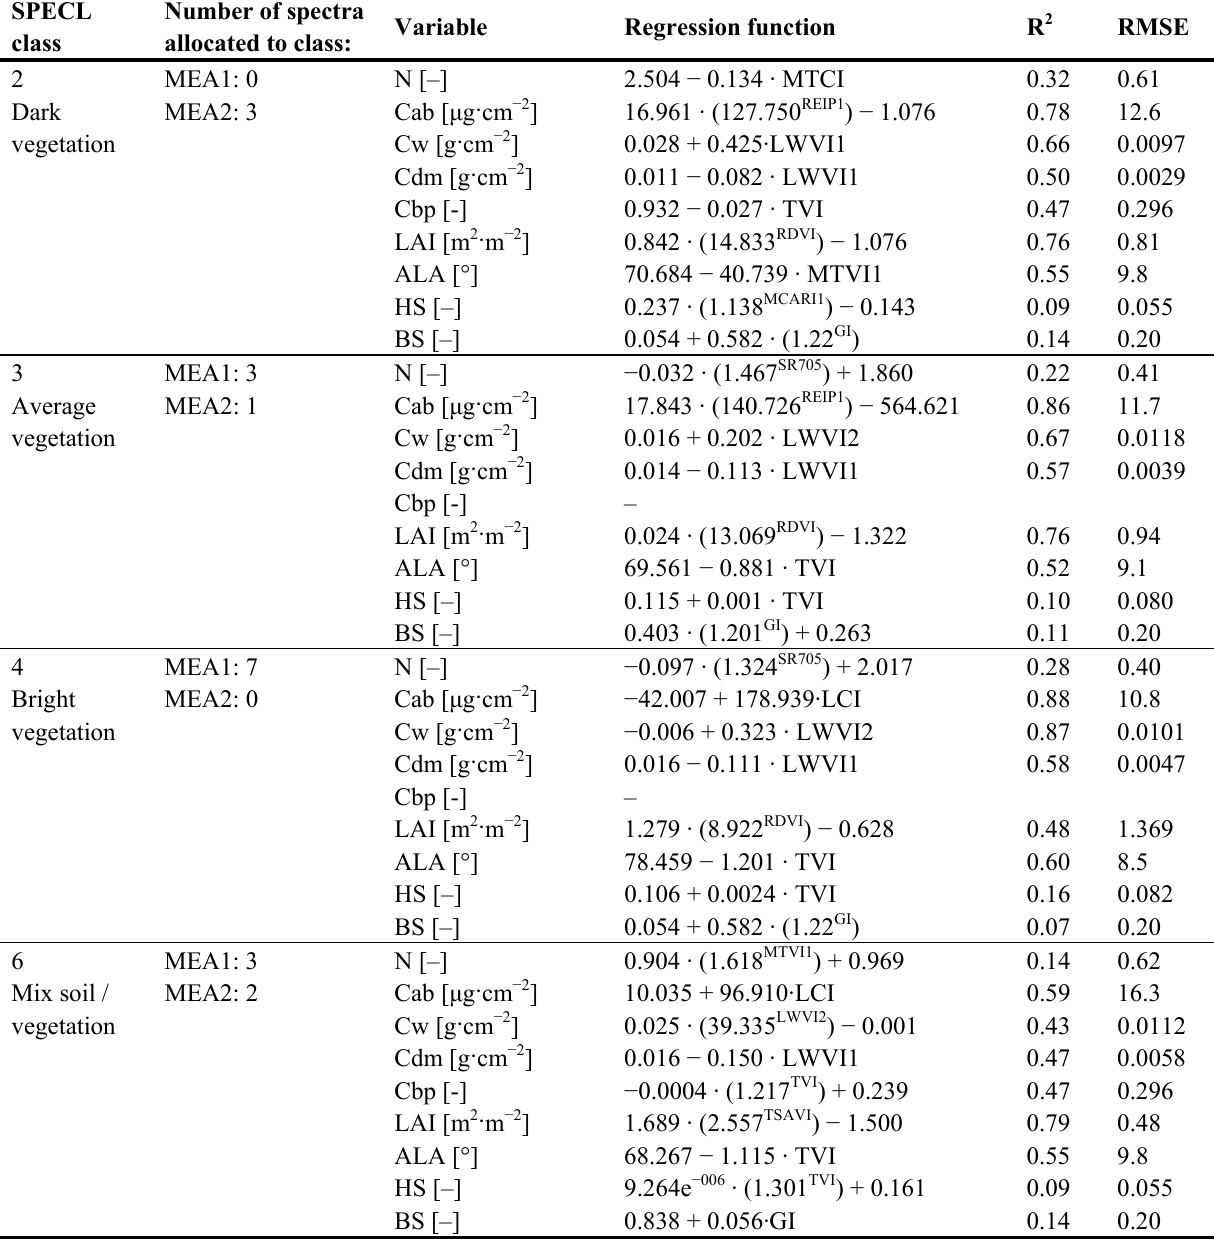
Table 7. Best performing predictive equations based on simulated spectra in different SPECL classes. The second column shows the results of the SPECL classification applied to the field spectra considered in this study, categorised according to the meadow on which they were taken. For a description of the VI abbreviations see Appendix II. For variables that have a fixed value in the LUT, no predictive equations could be